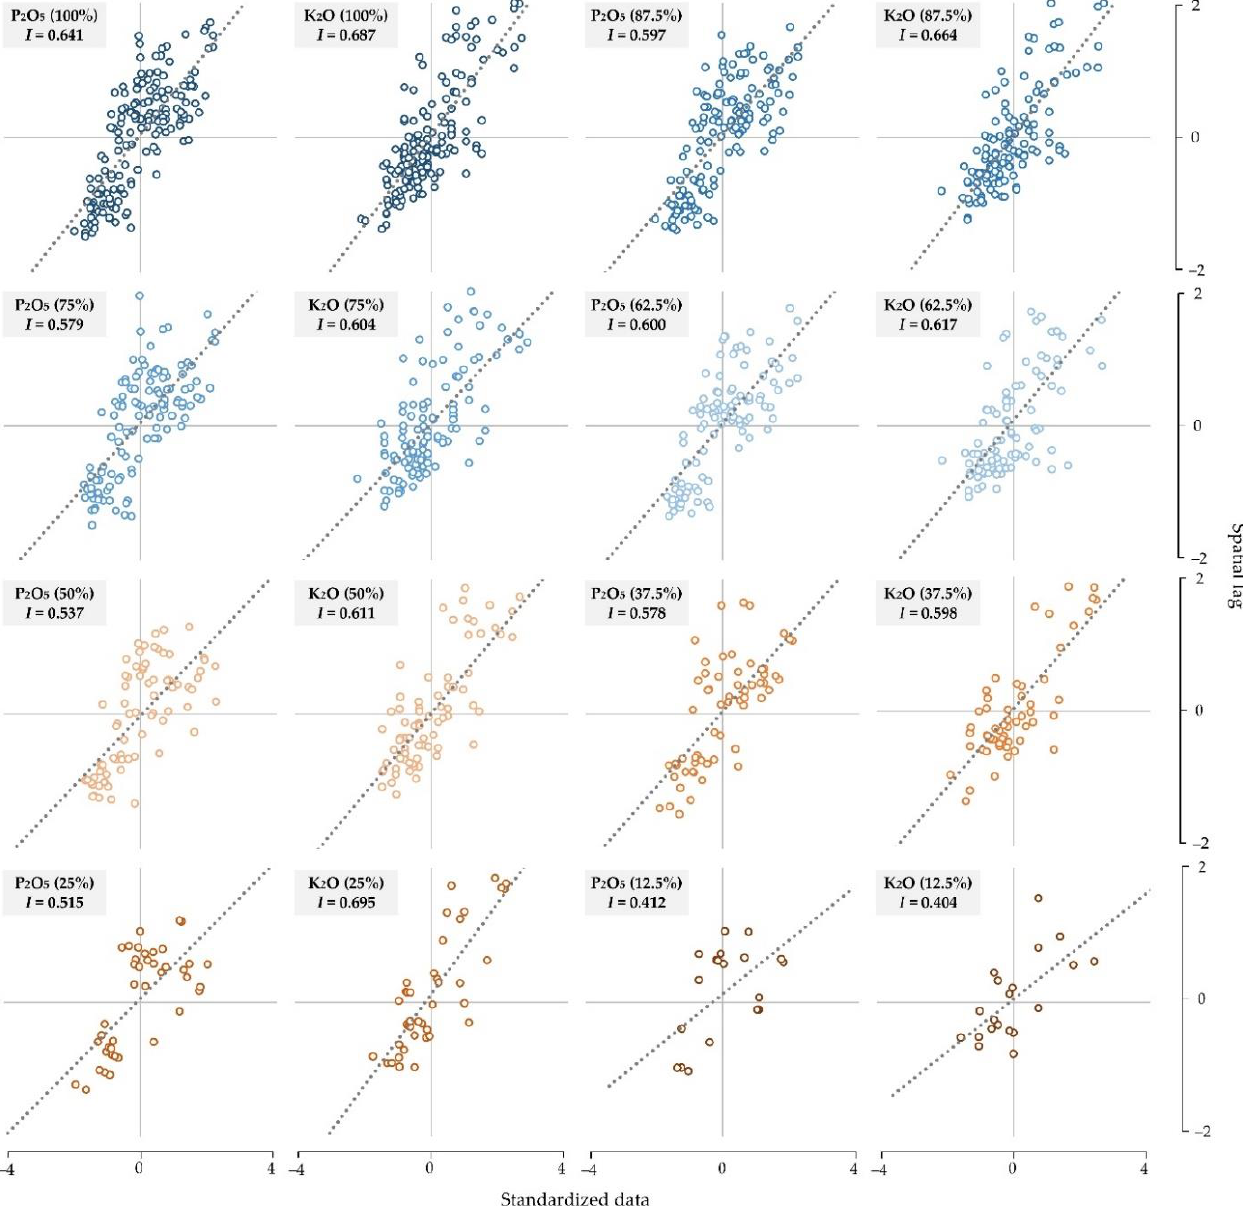
Figure 4. Moran ’ s I values of the eight soil subsets for P 2 O 5 and K 2 O. Figure 4. Moran’s I values of the eight soil subsets for P 2 O 5 and K 2 O. The optimal OK interpolation parameters per subset are shown in Appendix A, Table A1. The mathematical power model was determined as the best fit for all interpo- lation variants. Fitting autocorrelation ranges corresponded to those determined by the correlograms, increasing for 25% and 12.5% soil subsets. The highest R 2 v values were observed for denser soil subsets, especially for 62.5% and higher percentages of the